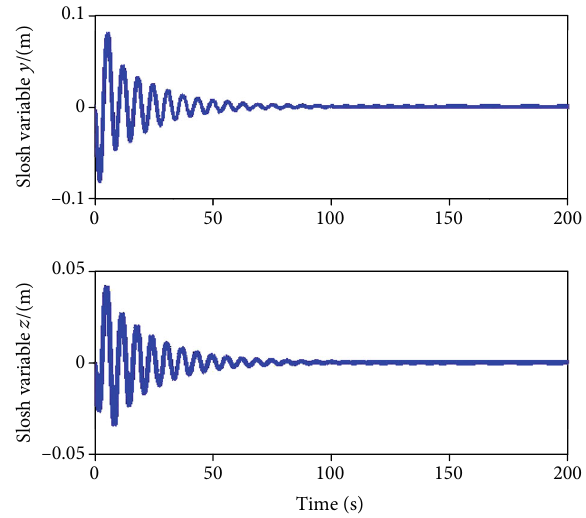
Figure 2: Time histories of angular velocities in Case 1.